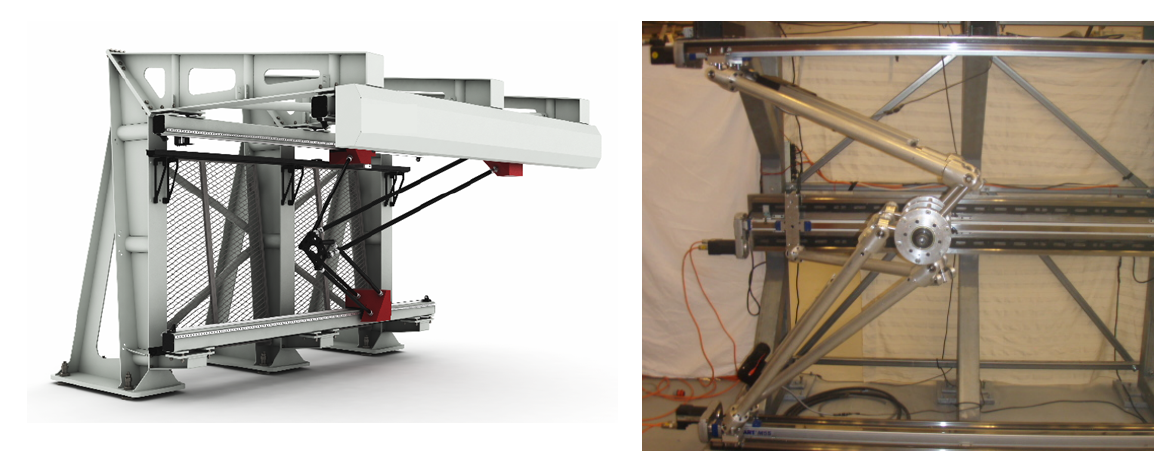
Figure 15: A 3 DOF implementation of the Gantry Tau robot where a traditional wrist must be mounted on the manipulated platform when tool orientation is controlled.